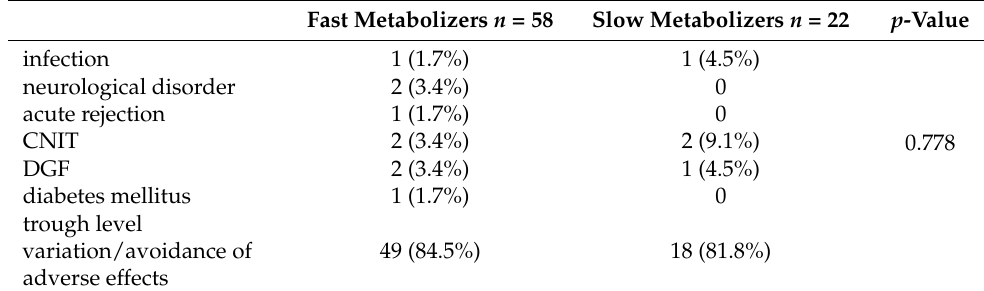
Table 2. Reasons for the switch from IR-Tac to